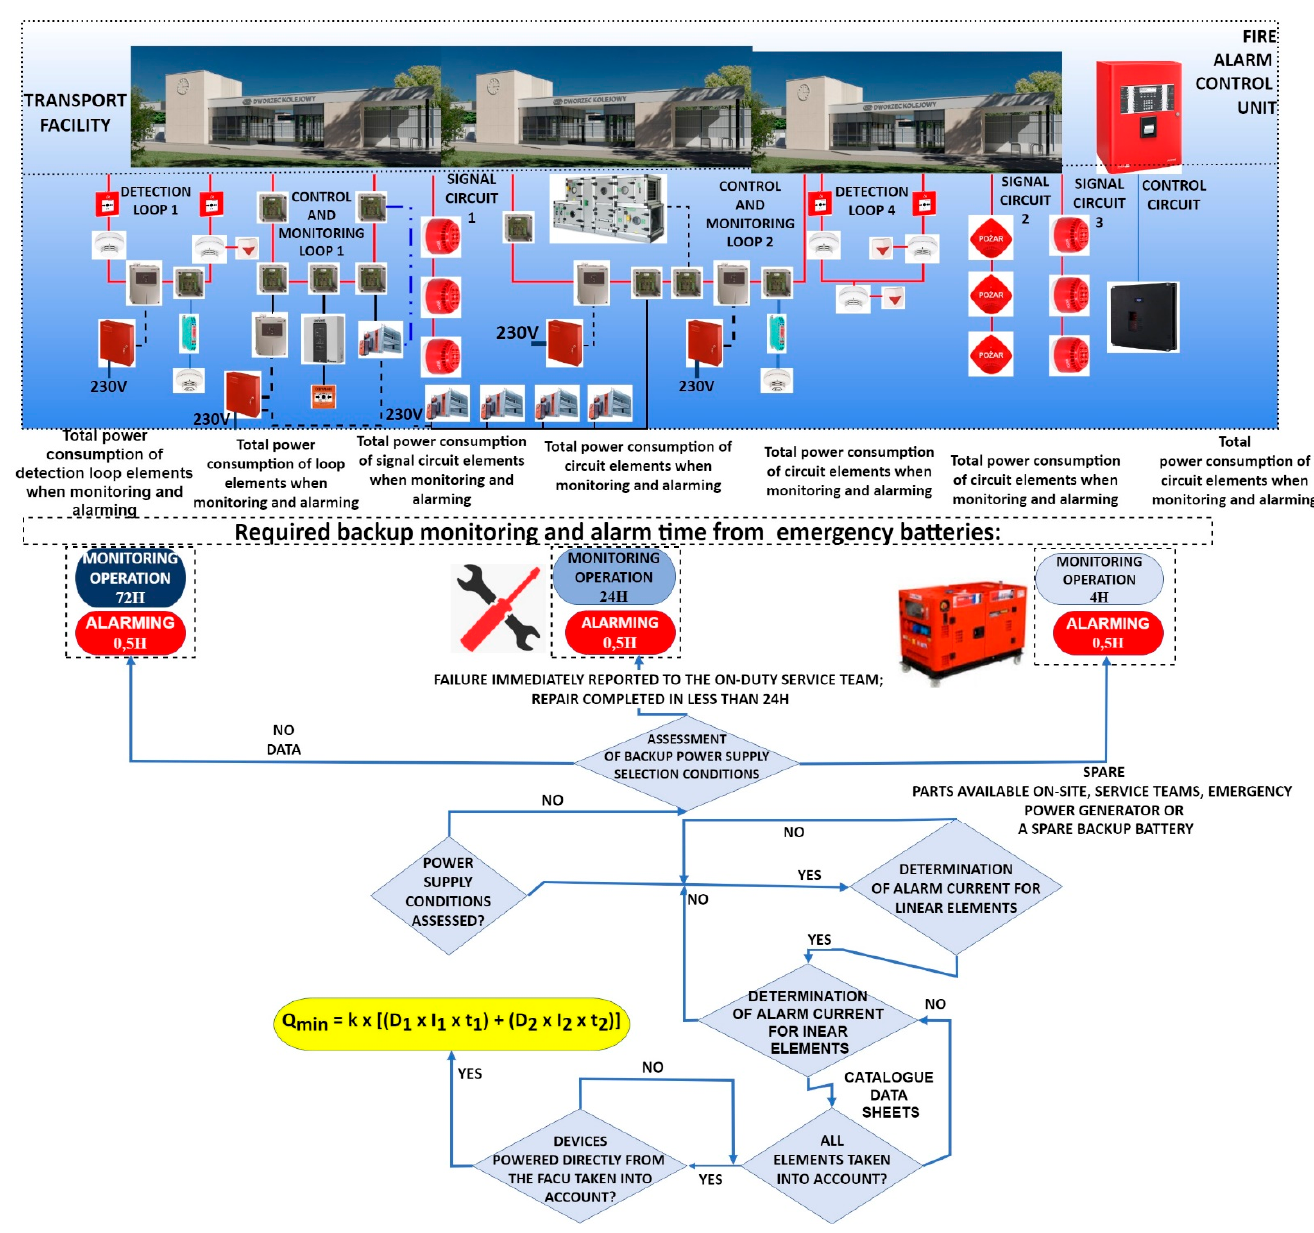
Figure 5. Scattered FAS energy balance determination graph, where: k-is the reserve coefficient, usually taken as 1.25, I 1 -determined FAS power consumption in the technical state of monitoring for the first fire system, t 1- required operating time of the first FAS in the technical state of monitoring, D 1 is the coefficient associated with battery capacity upon discharging with the I 1 current (the value should always be obtained from the battery manufacturer; in practice, 1 is adopted for the FAS), I 2 - determined power consumption for the first FAS in the technical state of alarm, t 2- required operating time of the first FAS and the technical state of alarm, D 2- coefficient associated with reduced battery capacity resulting from drawing large-value power under alarm conditions. In the case of typical FACU operating conditions, the adopted value can be 1; however, in the case of AWS, due to the possible broadcasting of a message over all speaker circuits and to all zones, this coefficient may reach a value up to 1.5, H-means on hour of operation (H = 60 min).